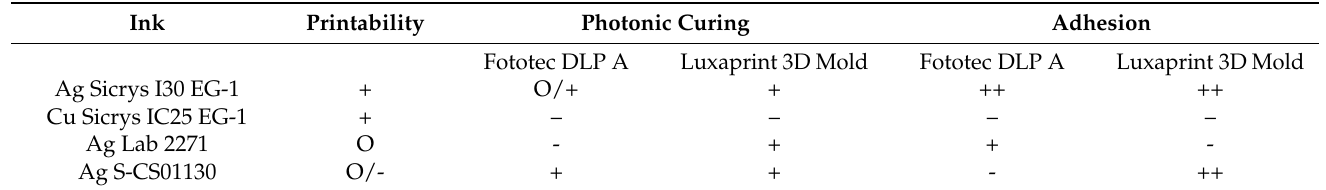
Table 3. Evaluation results of tested nano metal inks. Adhesion testing was done with a 3M